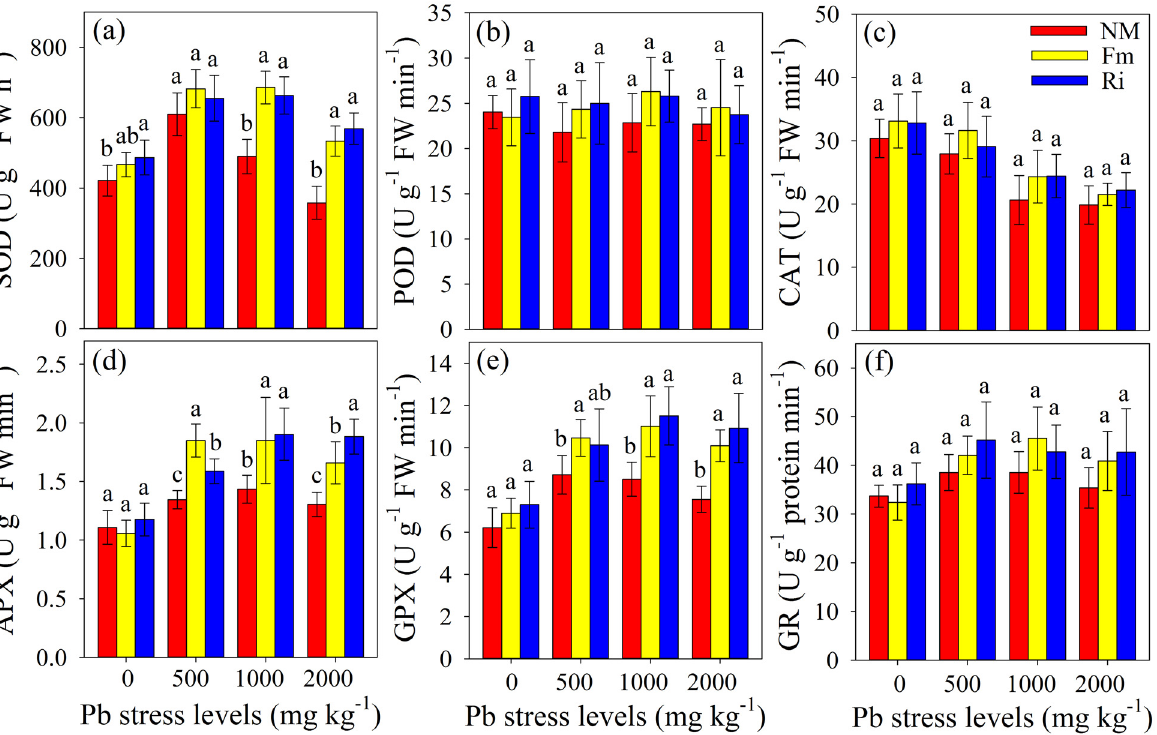
Fig 4. The SOD activity (a), POD activity (b), CAT activity (c), APX activity (d), GPX activity (e), and GR activity (f) in R . pseudoacacia leaves were affected by Pb stress levels and AMF inoculation. NM, non-inoculated control; Fm, inoculated with F . mosseae ; and Ri, inoculated with R . intraradices . The results are shown as the mean (n = 6) ± SD. The same letter indicates no significant difference among treatments (Duncan ’ s test, P < 0.05). Two-way ANOVAs were used to determine the significance of the effects of the Pb level (Pb), AMF inoculation (AMF), and their interactions (Pb × AMF) on those parameters, as shown in S4